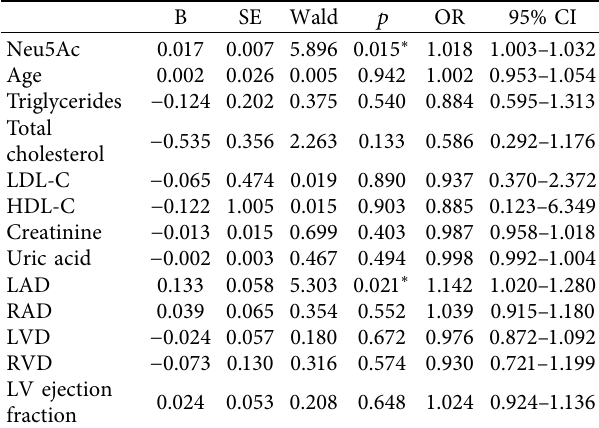
Neu5Ac: N-acetylneuraminic acid; LDL-C: low-density lipoprotein cho- lesterol; HDL-C: high-density lipoprotein cholesterol; LAD: left atrial di- ameter; RAD: right atrial diameter; LVD: left ventricular diameter; RVD: right ventricular diameter; LV: left ventricular. ∗ p < 0 . 05 for significant